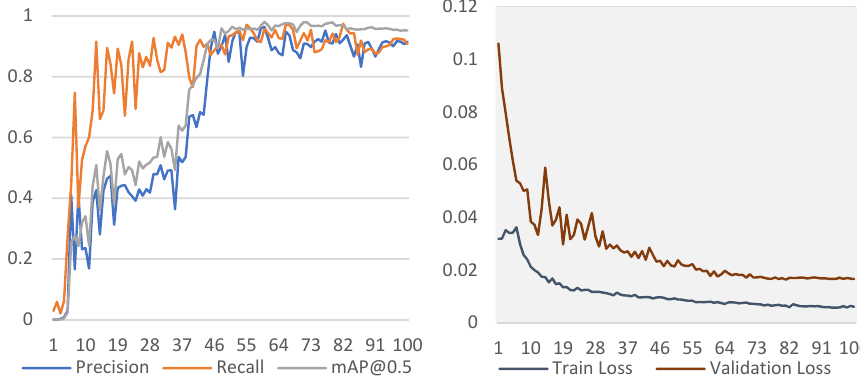
Figure 5. Change of performance metrics and losses for YOLOv3.